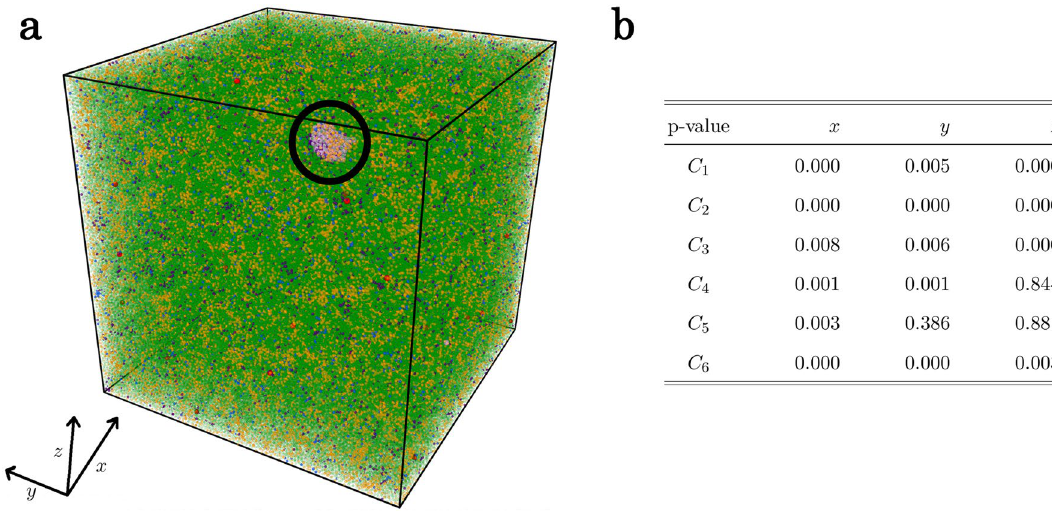
Figure 4. Early nucleation stage for Ta. ( a ) Snapshot of the simulation with 1 million atoms along isotherm T = 1900 K showing the onset of nucleation when the first nucleus starts to grow (highlighted by the black circle). Atoms have been coloured according to the cluster they belong to (see Fig. 1d). ( b ) p-values computed on the projection of atomic positions on each direction of the box from a Kolmogorov–Smirnov test against the uniform